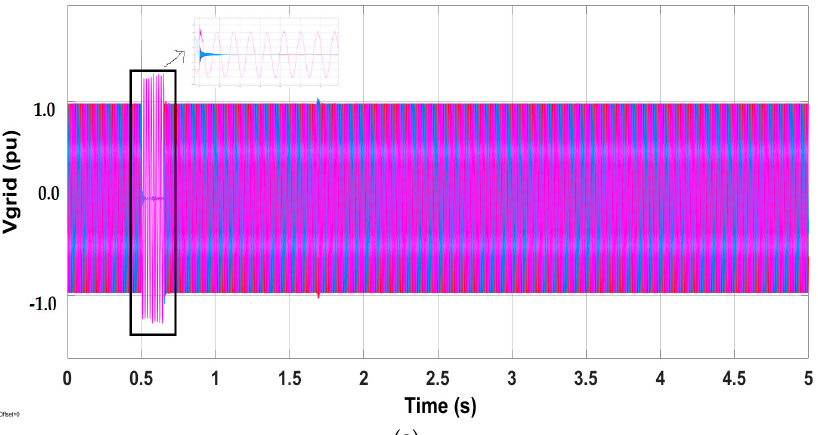
Table 1. Performance index enhancement with the proposed control scheme for symmetrical and asymmetrical faults.